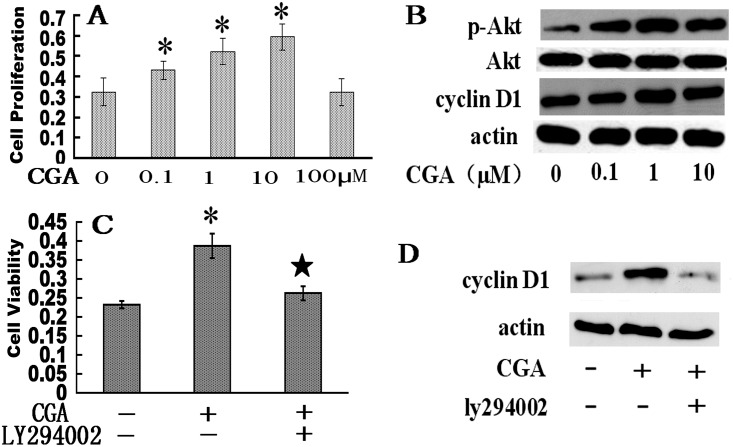
Effect of CGA on proliferation of rat BMSCs.(A) MTT assay of cell viability. Each column represents the mean ± SD of optical density values.*p < 0.05 vs. 0 μM group. (B) Western blots of p-Akt, Akt, and cyclin D1expression in cells exposed to CGA. β-Actin was used as the loading control. (C) Viability in cells exposed (+) to 10 μM CGA and 2 μM LY294002 (PI3K/Akt inhibitor). Each column represents the mean ± SD of the optical density values. *p < 0.05 vs. control (–/–) group. ★p < 0.05 vs. CGA+/ LY294002+ group. (D) Western blot of cyclin D1 expression in cells exposed (+) to 10 μM CGA and 2 μM LY294002. β-Actin was used as the loading control.